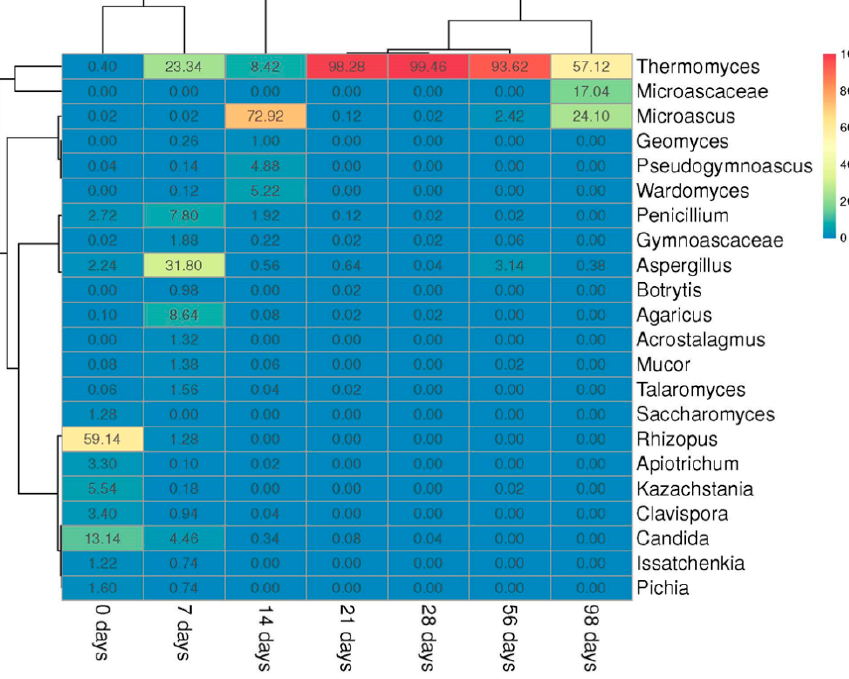
Figure 3. The heat map of the distribution of the most relatively abundant (>1%) fungal genera on days 0, 7, 14, 21, 28, 56, and 98 of composting. The genus abundance was calculated by dividing the sequence proportions by the total sequence count in the sample. The relative abundance of the genus is shown by the color.